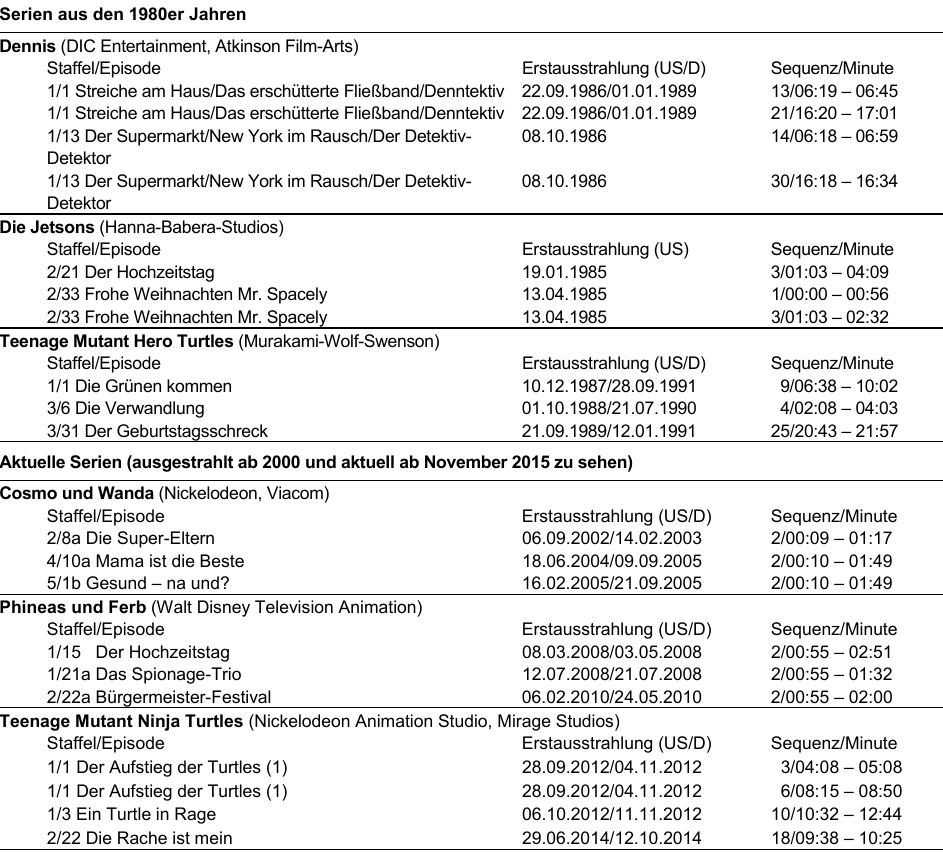
Tabelle 1 : Merkmale der analysierten Serien bzw. Folgen und Sequenzen Serien aus den 1980er